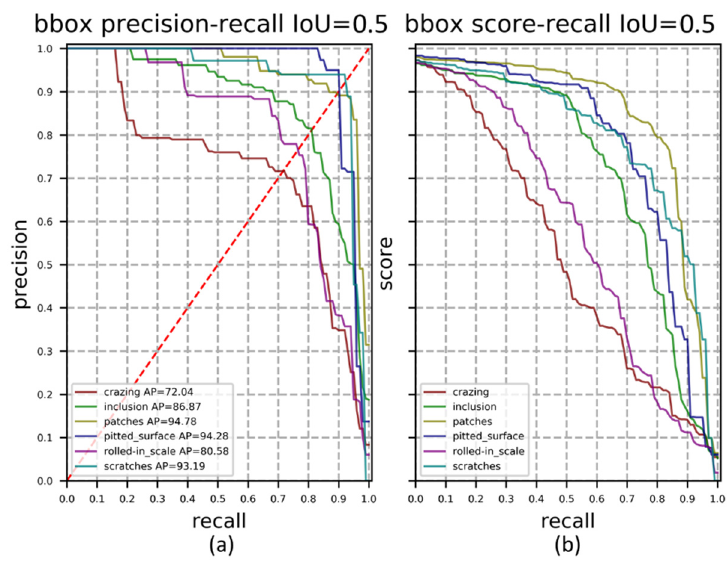
Figure 9. ( a ) P-R curve and BEP; ( b ) score-recall curve. In red dotted line, there have recall equals to precision. The point where the P-R curve intersects the red line is the break-even point. The detection results are shown in Figure 10.